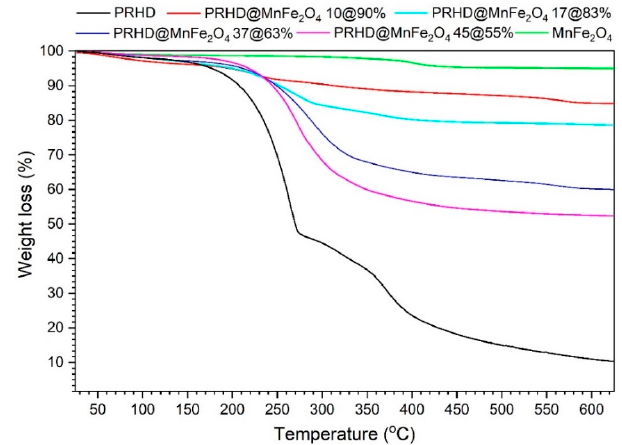
Figure 3. TGA analysis of PRHD@MnFe 2 O 4 hybrid materials.